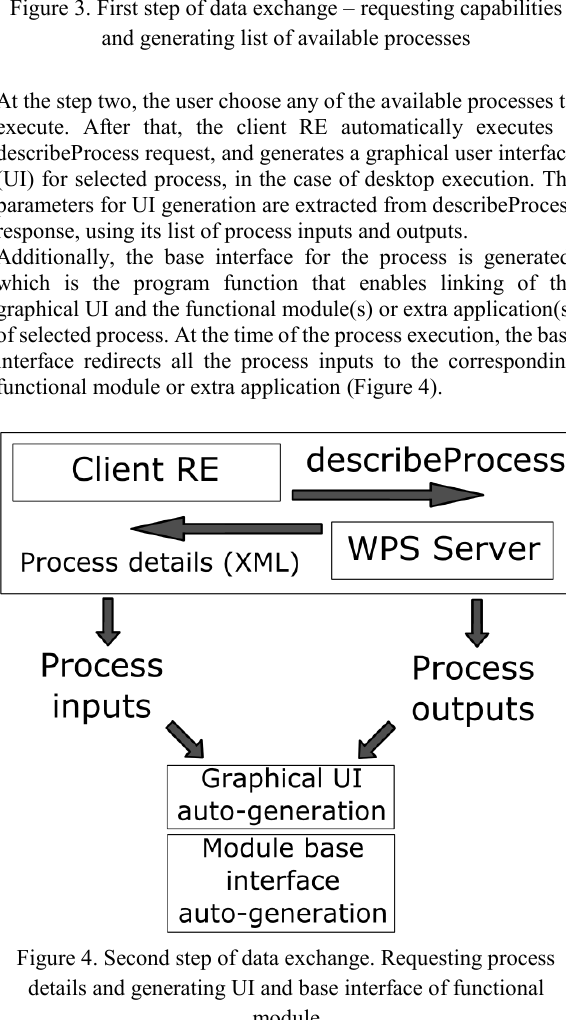
Figure 2. ER-map of process components located on server and